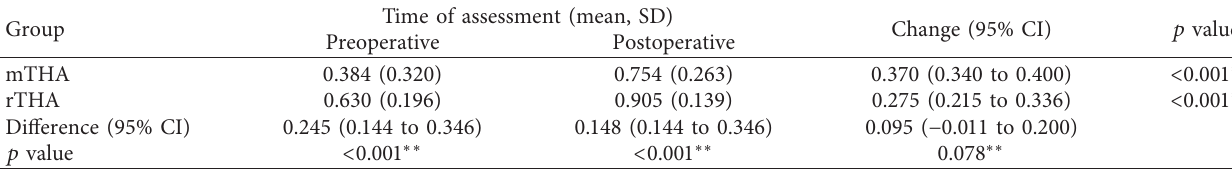
Table 2: Mean pre- and postoperative EQ-5D utility scores according to group. The change represents the improvement between the pre- and postoperative EQ-5D utilities, and the difference represents the difference between the groups pre- and postoperative and for change in the EQ-5D utilities.